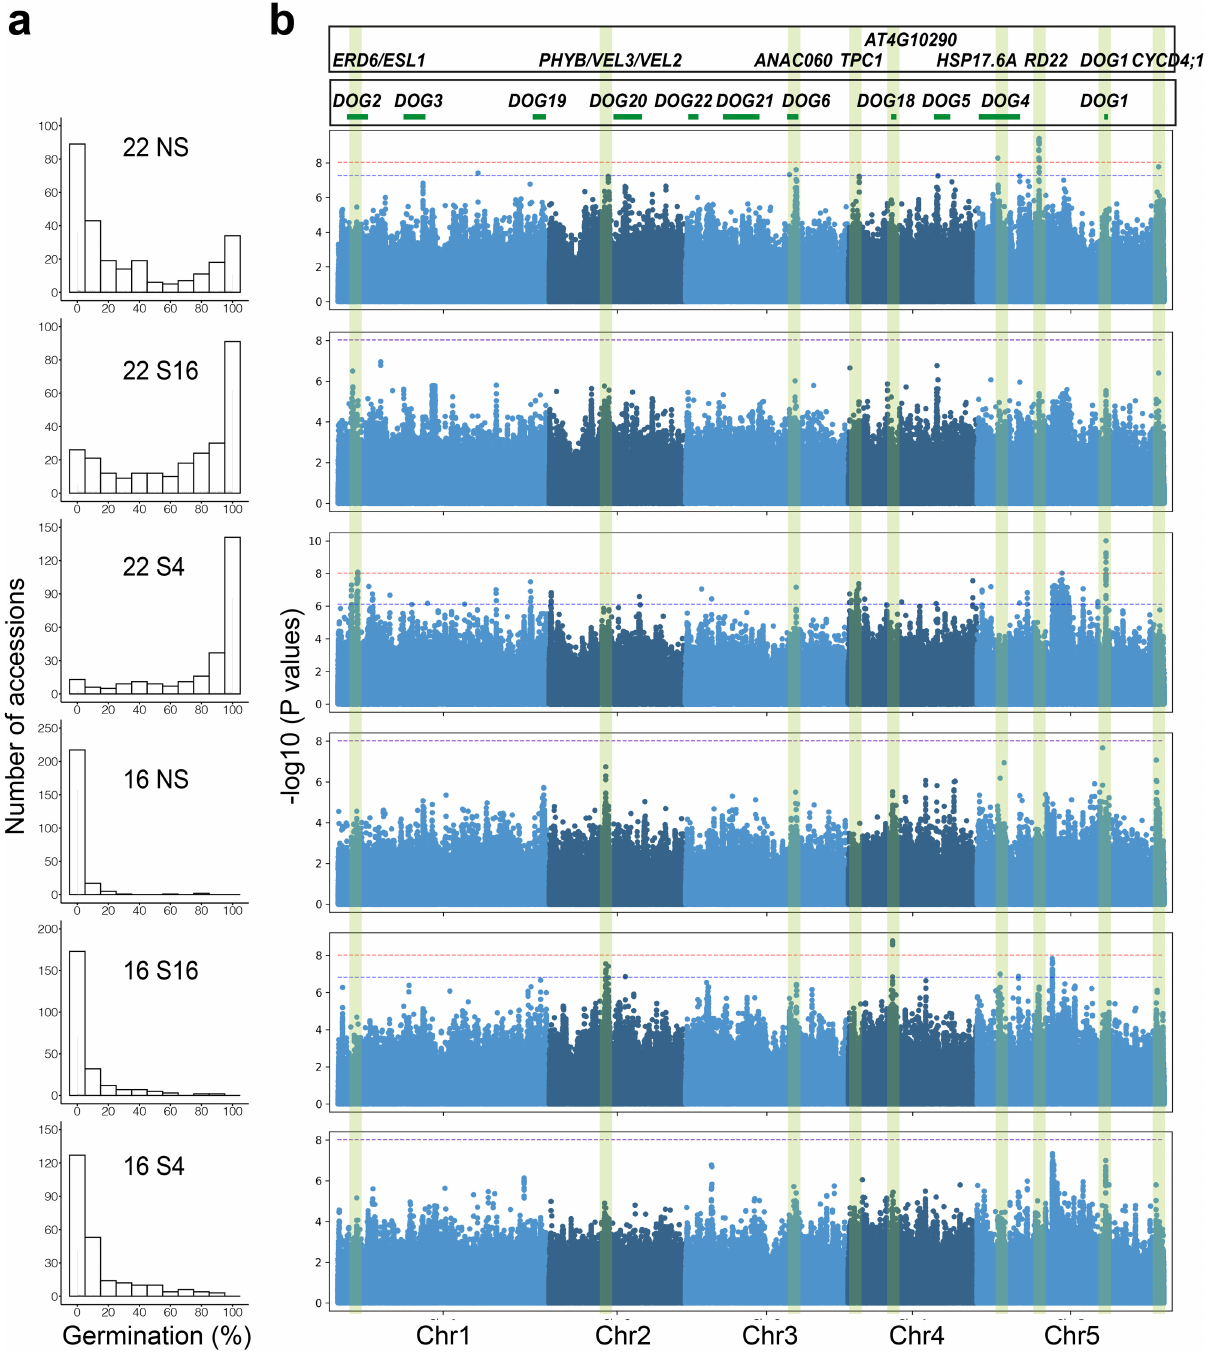
Fig.1|Genome-wideassociationidenti fi esalocusonchromosome2witharole in seed dormancy control. a Percentage of accessions with different germination frequencies when grown at either 16°C or 22°C and sown either without prior strati fi cation (NS) or after dark strati fi cation at 4°C (S4) or at 16°C (S16).